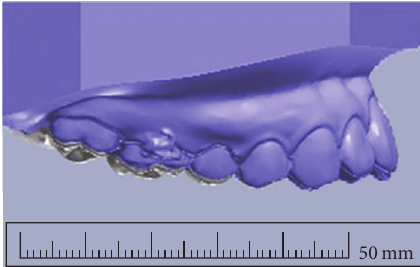
Figure 5: Clinical assessment by superimposition of 3D scans of before (gray) and after (blue) intrusion dental casts.